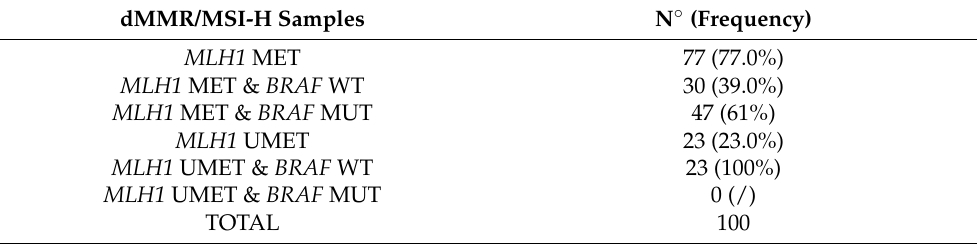
Table 2. Molecular profile according to MLH1 methylation